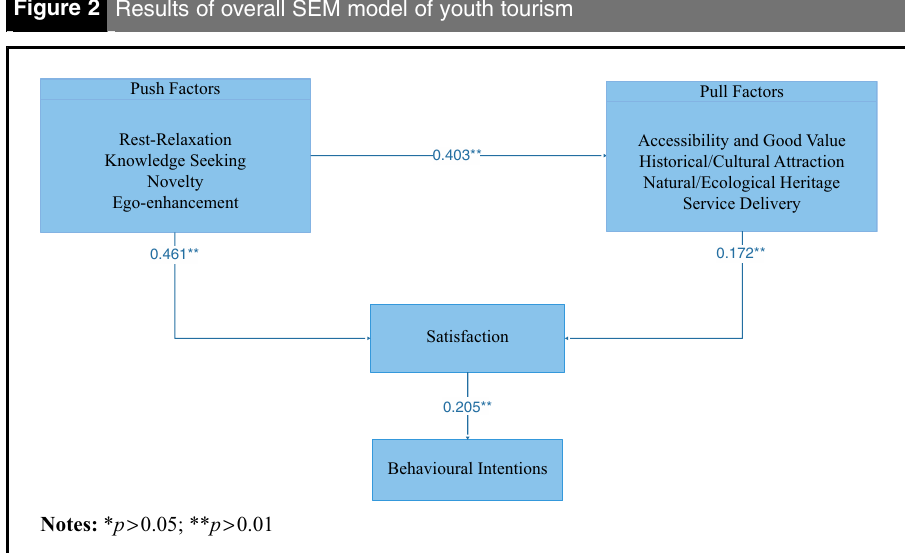
Figure 2 Results of overall SEM model of youth